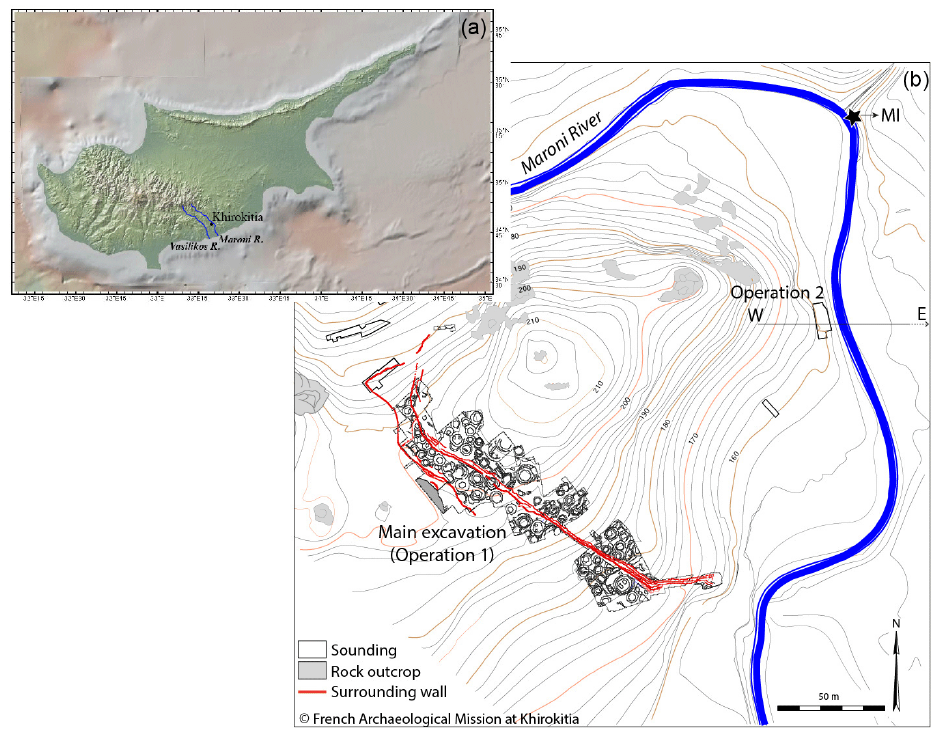
Figure 4. (a) General location of the Pre-Pottery Neolithic site of Khirokitia and of Vasilikos Valley, mentioned in the text. (b) Topographical map of Khirokitia illustrating the position of the site in relation to the Maroni River and the location of the different studied areas.